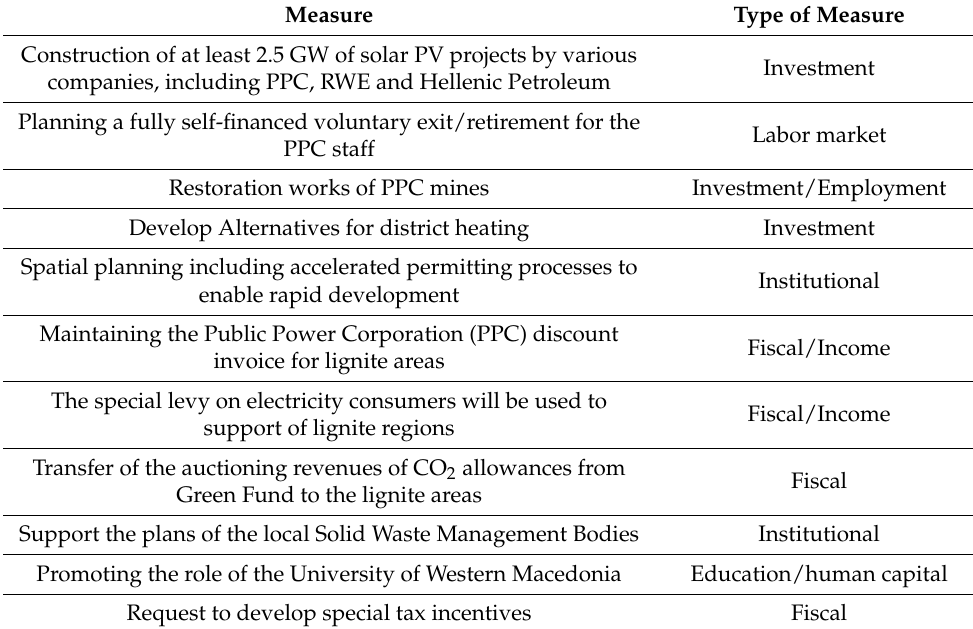
Table 1. The indicative measures within the Just Transition Development Plan, Source: [19].